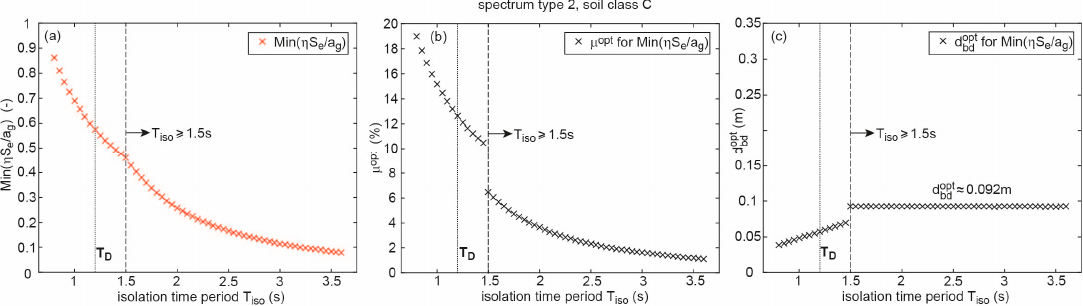
Figure 11. Optimization trajectories for ( a ) T iso = 1.49 s and ( b ) T iso = 1.5 s for spectrum type 2 with soil class C.